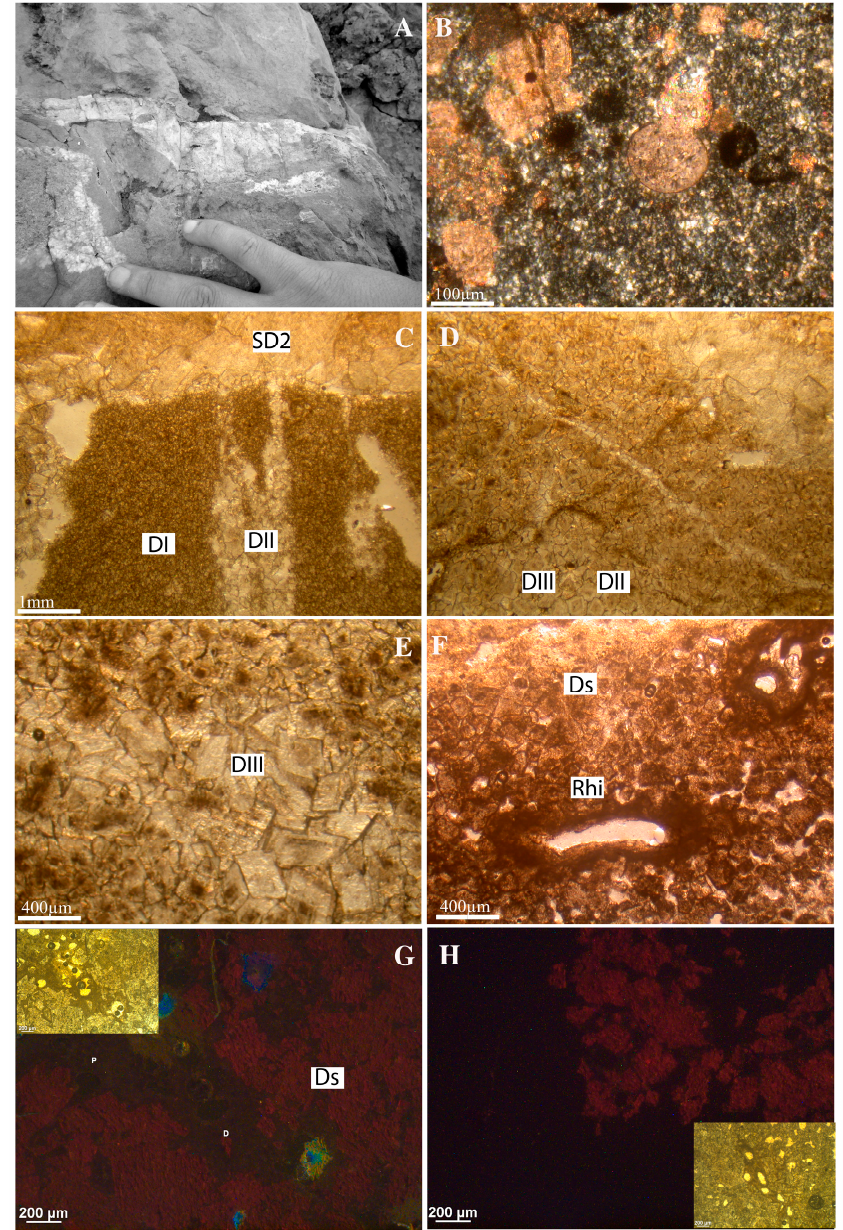
Figure 9. ( A – H ): Photomicrographs of dolomite and calcrete phases. ( A ) Calcrete profile displaying pronounced chert lenses and geode filled by saddle dolomite (lower left part). Spelek section. ( B ) Thin section, polarized light, same sample as Figure 3A; cryptocrystalline and fine-grained silica in a planktonic foraminiferal wackestone. Spelek section. ( C ) Thin section, plane light, brown facies representing the “replacement dolomite—DI”, cross-cut by fracture filling with DII medium crystalline dolomite. The upper most part represents dirty saddle dolomite “SD2”. Spelek section. ( D ) Thin section, plane light; transitional stage from DII (central part) to transparent dolomite DIII (toward leftmost lower part), suggesting that the replacement process is still functioning at this stage. Sulauk section. ( E ) Thin section, plane light; euhedral, transparent DIII filling a large void, where a few crystals are still shown as preserved traces of the former dolomites DII / DI, supporting the hypothesis of a replacement process during the early stage of diagenesis (see text). Sulauk section. ( F ) Thin section, plane light; the loose saccharoidal dolomite matrix (Ds) is significantly a ff ected by the calcretization process; note the trace of a rhizoliths (Rhi) in the lower part of the picture. Spelek section. ( G ) Thin section, plane light and cathodoluminescence; saccharoidal dolomite Ds sharing the same physical properties and dull red luminescence as DII and DII. Ds formed probably as a result of